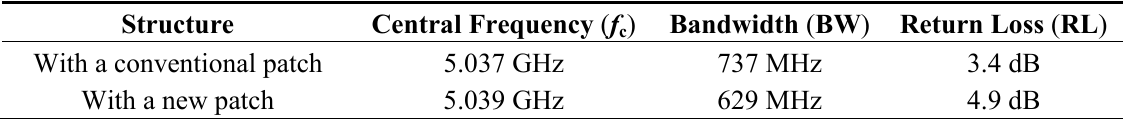
Table 6. Comparison between the performance of both dual-mode filters considering ε = 2.62 and tan δ ⊥ = r ⊥